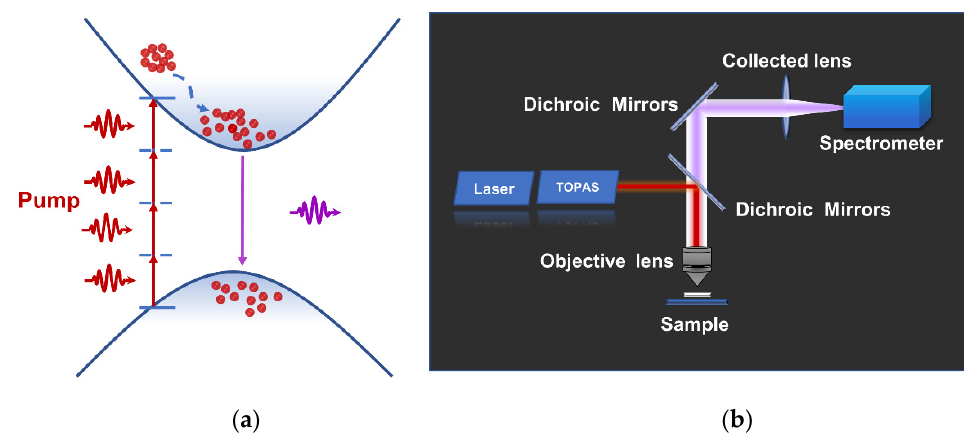
Figure 3. Schematic diagram for MPA upconversion lasing and device schematic. ( a ) Energy diagram indicating the mechanism for upconversion transition in virtual energy levels and bandgap by simultaneous MPA. ( b ) Setup of the MPA (schematic) for the MQWs based on a tunable fs-pulsed laser.